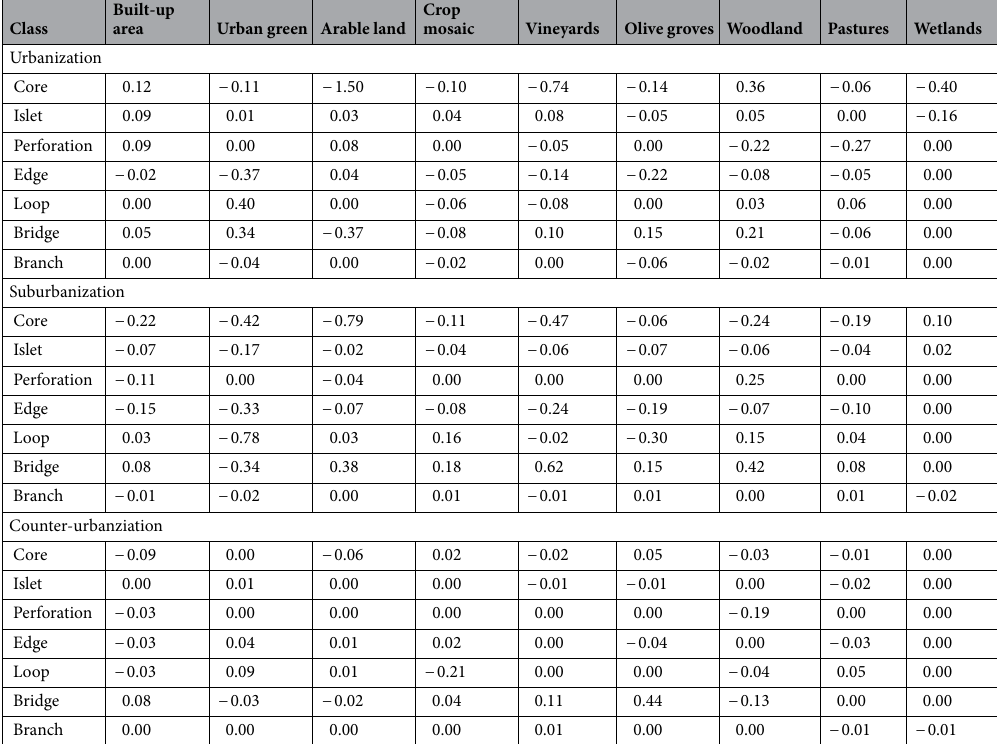
Table 3. Per cent annual change over time (%) in the mean patch size by developmental stage and structural (rows)/functional (columns) class in metropolitan Rome.